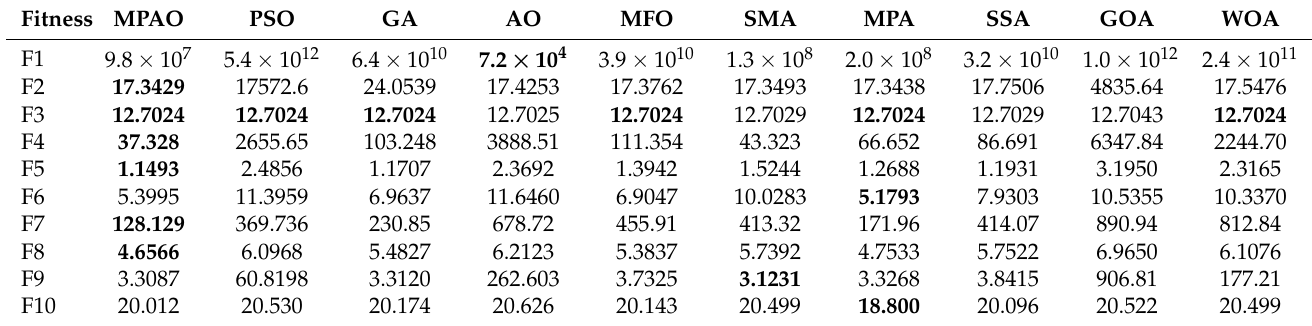
Table 2. Average of the fitness function.